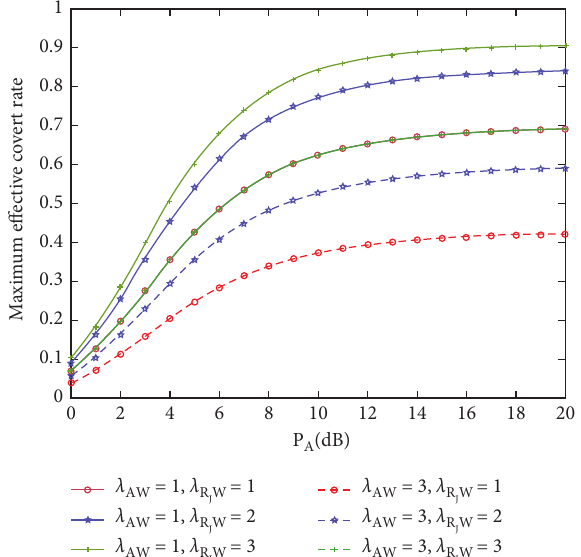
Figure 7: Maximum effective covert rate versus P value of | h AW | 2 and | h R ε � 0 . 05, and N R � 3.